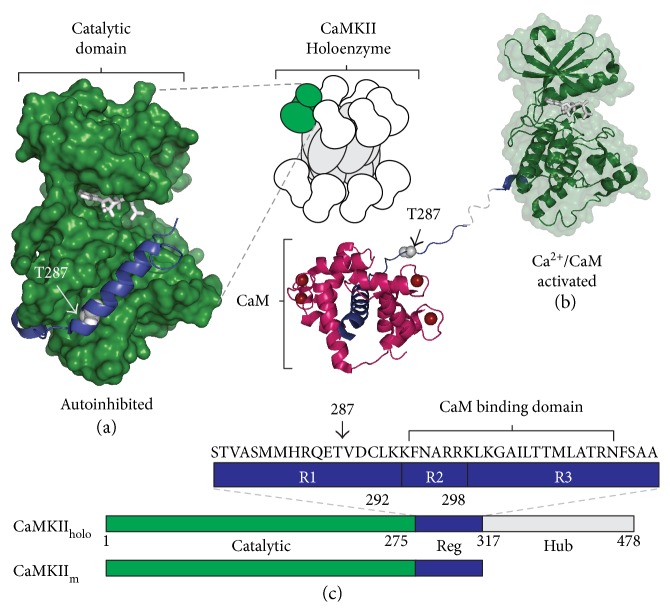
Molecular structure and schematic models for CaMKII autoregulation and activation. (a–c) Structural representations of CaMKII's catalytic domain (green), autoregulatory domain (ARD) (blue), and hub domain (gray). (a) Illustration of CaMKII holoenzyme with detailed view of the catalytic domain. Adapted X-ray crystal structure shows monomeric human CaMKIIδ11–309 (PDB ID: 2VN9; [11]) in the autoinhibited state with the ARD (blue) and modified to include ATP in the active site (PDB ID: 1ATP; [71]). (b) hCaMKIIδ11–335 activated (PDB ID: 2WEL; [11]) by Ca2+ (red spheres) and calmodulin (CaM) (magenta) and exposing T287 (white) for autophosphorylation. (c) Linear schematic of CaMKII holoenzyme (CaMKIIholo) and monomeric CaMKII (CaMKIIm, or CaMKII1–317). Expanded view shows the ARD (blue) with subdivisions R1 (T287 containing region) and R2/R3 (CaM-binding region) [72].